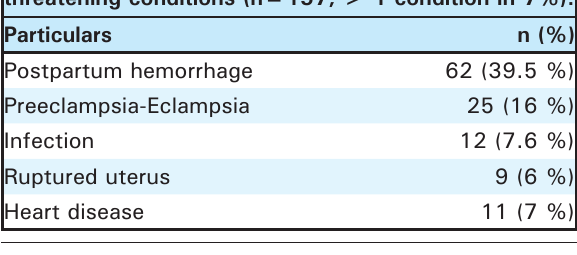
Table 3. Critical intervention or intensive care admission (n=157).